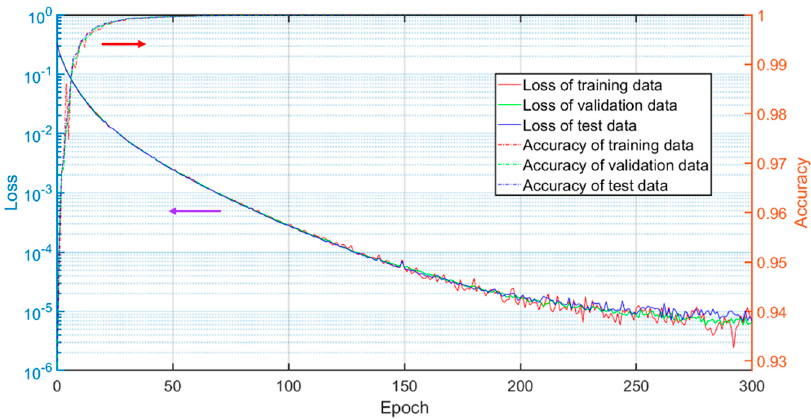
Figure 4. Loss and accuracy versus epoch during the training process.